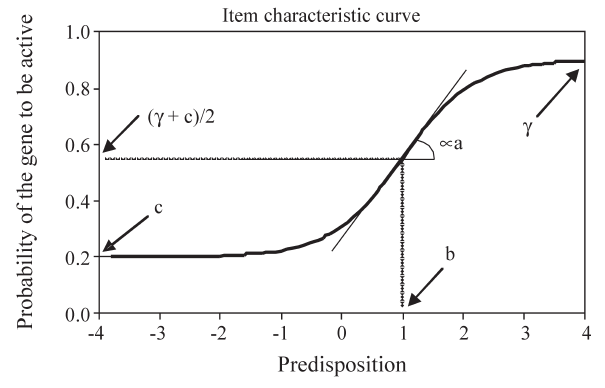
Figure 1 - Example of a graphic of an